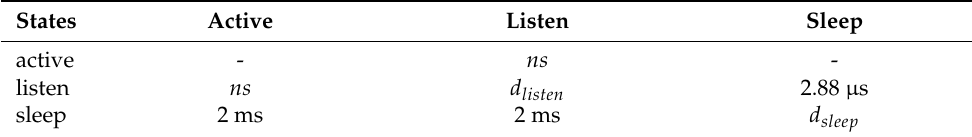
Table 2. Average transition times for ONU state transitions derived by